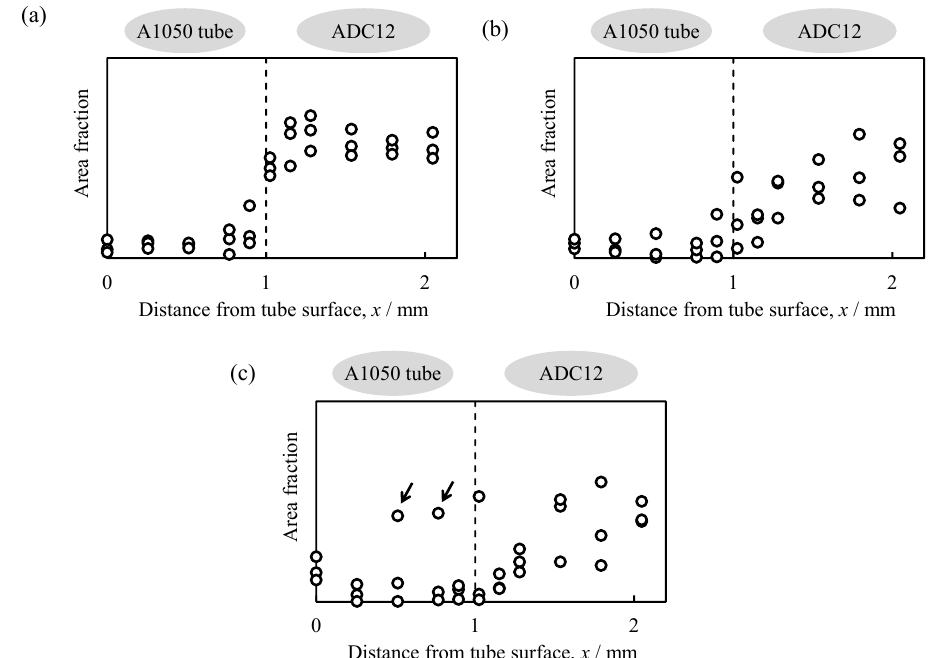
Figure 8. Distribution of the area fraction of elemental Si as a function of distance from the surface of the A1050 tube x for ( a ) ADC12 ‐ precursor ‐ bonded A1050 tube; ( b ) ADC12 ‐ foam ‐ filled A1050 tube with t H = 8.5 min; and ( c ) ADC12 ‐ foam ‐ filled A1050 tube with t H = 11 min.